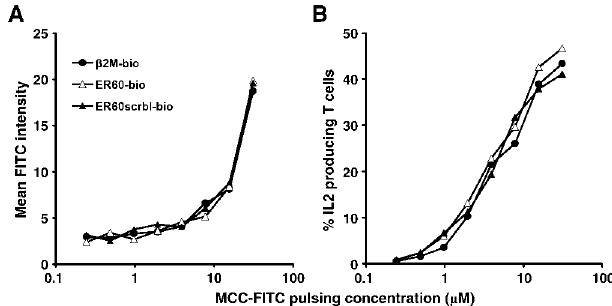
Figure 4. On Real APCs, Endogenous Peptides Do Not Affect T Cell Activation by Agonist Peptides CH27 cells were cultured with 1 mM b 2m-bio, ER60-bio, or ER60scrbl-bio peptides for 20 h at 37 8 C. After washing, cells were incubated with MCC- FITC peptides at the indicated concentrations for 30 min before washing. (A) The level of MCC-FITC on CH27 cells after pulsing, as measured by flow cytometry. (B) AD10 T cells were mixed with CH27 cells pulsed with MCC-FITC at the indicated concentrations and IL2 production was measured by intra- cellular staining after 7 h. Data are representative of three independent